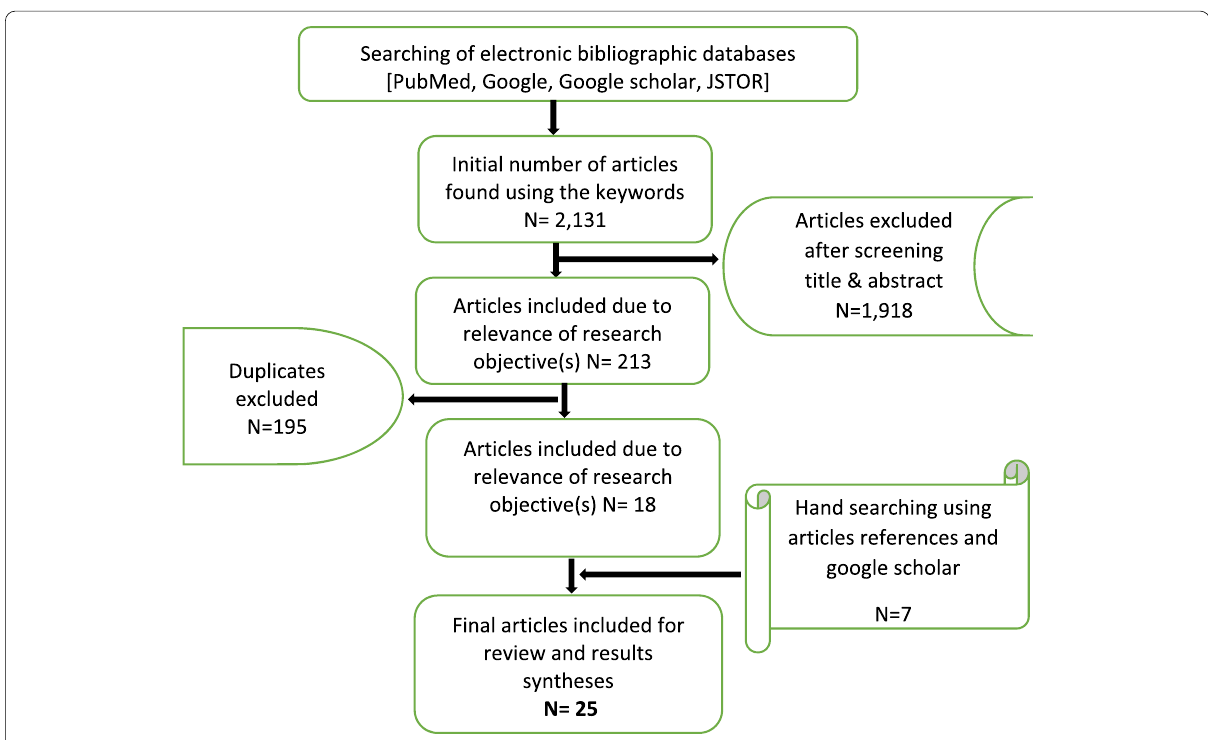
Fig. 1 Flowchart of the number of literature searched and